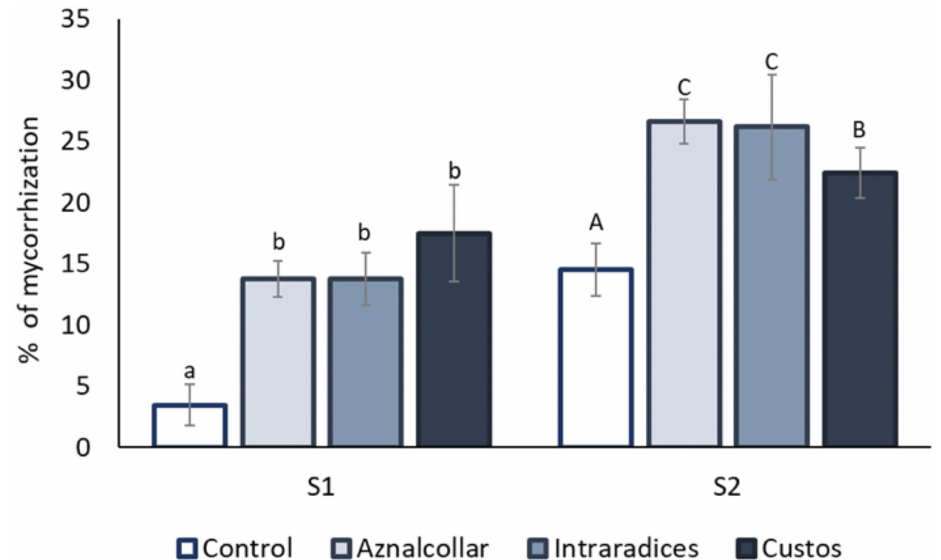
Figure 4. Percentages of root mycorrhization for the three AMF selected (Aznalcollar, Intraradices, and Custos). Values are means ( n = 5). Different letters indicate significant differences between treatments ( p < 0.05) according to the Duncan post-hoc test: lowercase for soil 1 (S1) and capital letters for soil 2 (S2).